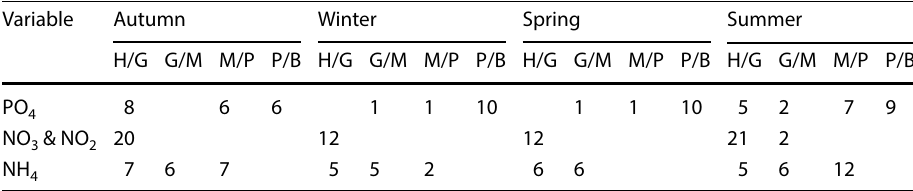
Table 1 Seasonal water quality classes (European Union Water